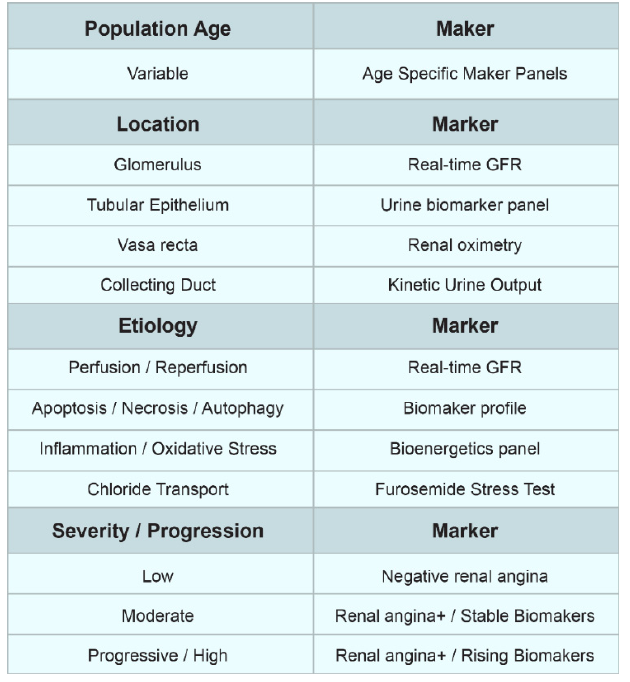
Figure 3. Future of biomarkers of AKI. Abbreviations: GFR, glomerular filtration rate.